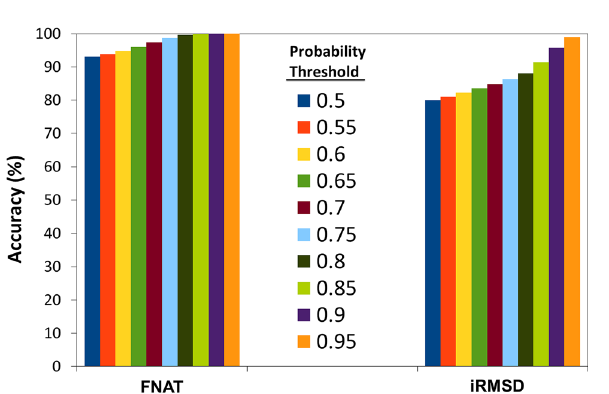
Figure 2. Comparison of prediction performances. The prediction performances of the SVM based prediction models (PCPIP_FNAT and PCPIP_iRMSD) for native and non-native like complexes from the Apo-Holo dataset were compared against 10 different types of scoring functions. Receiver operating characteristic (ROC) plots were created by calculating the true positive rate (TPR; Y axes) and false positive rate (FPR; X axes). PCPIP stands for Protein Complex Prediction by Interface Properties. Area under curve (AUC) values for each of the methods is also provided. Benchmarking was performed using the FNAT ( A ) and iRMSD ( B ) definitions based sub-datasets from the Apo-Holo validation set where native-like complexes were defined by FNAT > 0.8 and iRMSD < 5 Å, respectively and non-native like complexes were identified using FNAT ≤ 0.8 and iRMSD ≥ 15 Å, respectively.